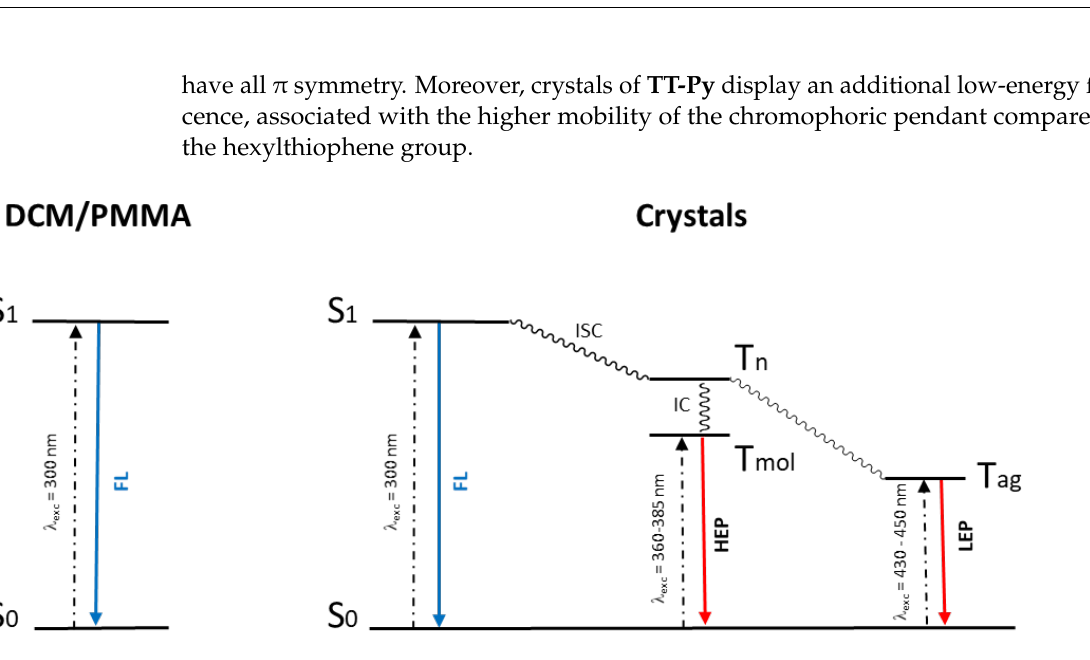
Figure 10. Energy level diagrams showing transitions associated with fluorescence (blue arrows) and phosphorescence (red arrows) for TT-HThio and TT-HThio 3 at 298 and 77K.